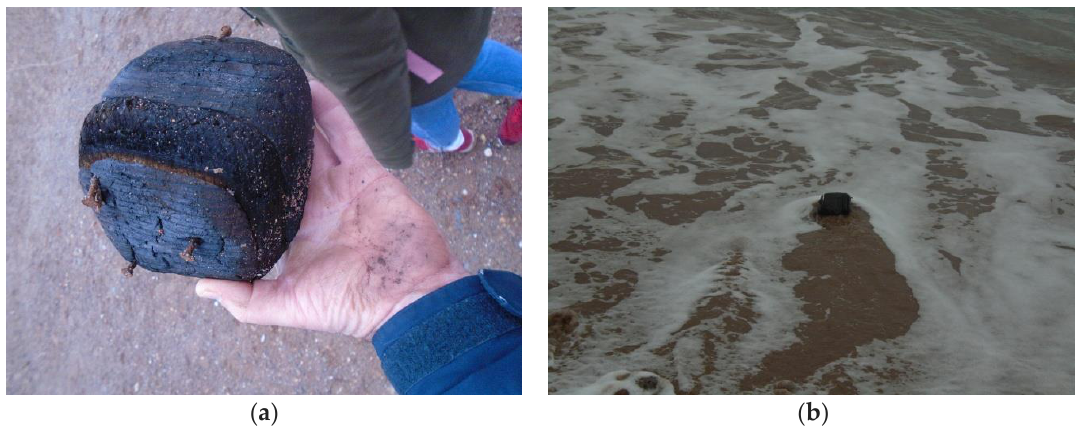
Figure 23. Mud from Langstone Point.